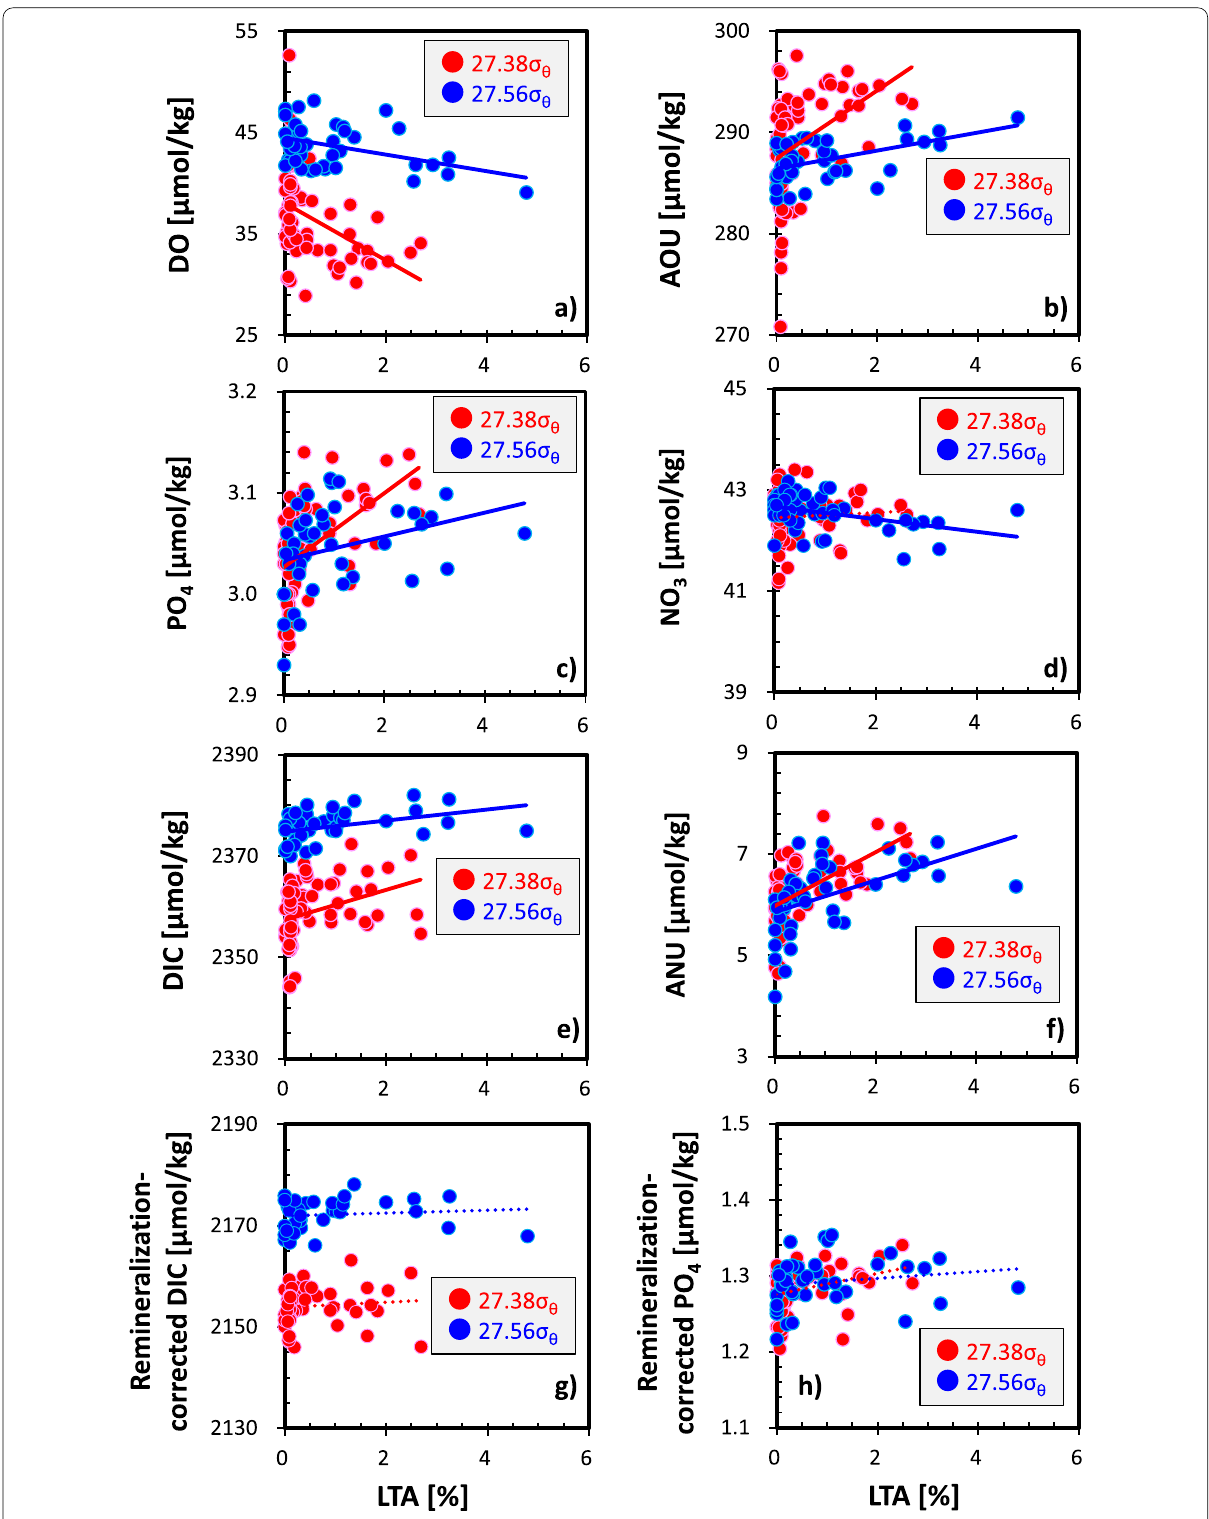
Fig. 8 Relationships between DO ( a ), AOU ( b ), PO 4 ( c ), NO 3 ( d ), DIC ( e ), ANU ( f ), remineralization-corrected DIC ( g ), and remineralization-corrected PO 4 ( h ) and LTA value on the studied isopycnal surfaces (27.38σ θ : red circles; 27.56σ θ : blue circles). Solid (dotted) lines indicate statistically significant (insignificant) regressions ( p <